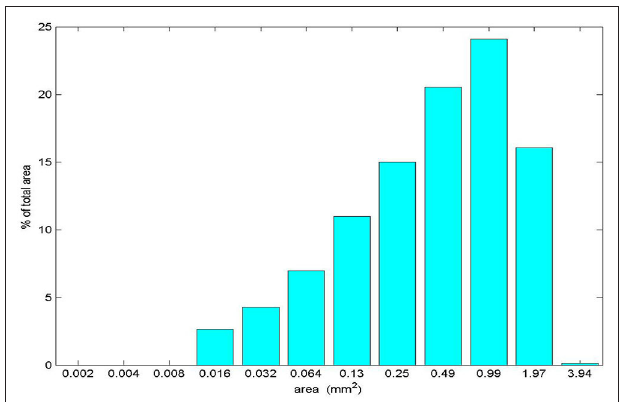
FIGURE 2 | Size distribution of wear particles for brass pin sliding on hard steel (load